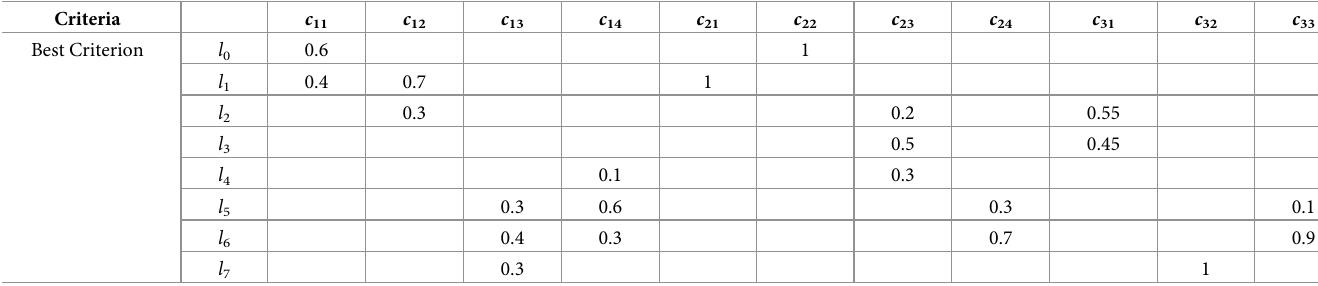
Through Eqs (8)–(10), the following specific linear programming model are constructed based on Eq (13). The final subjective weight w s Table 6. The linguistic label for fuzzy preferences of the best criterion over all criteria. Criteria Best